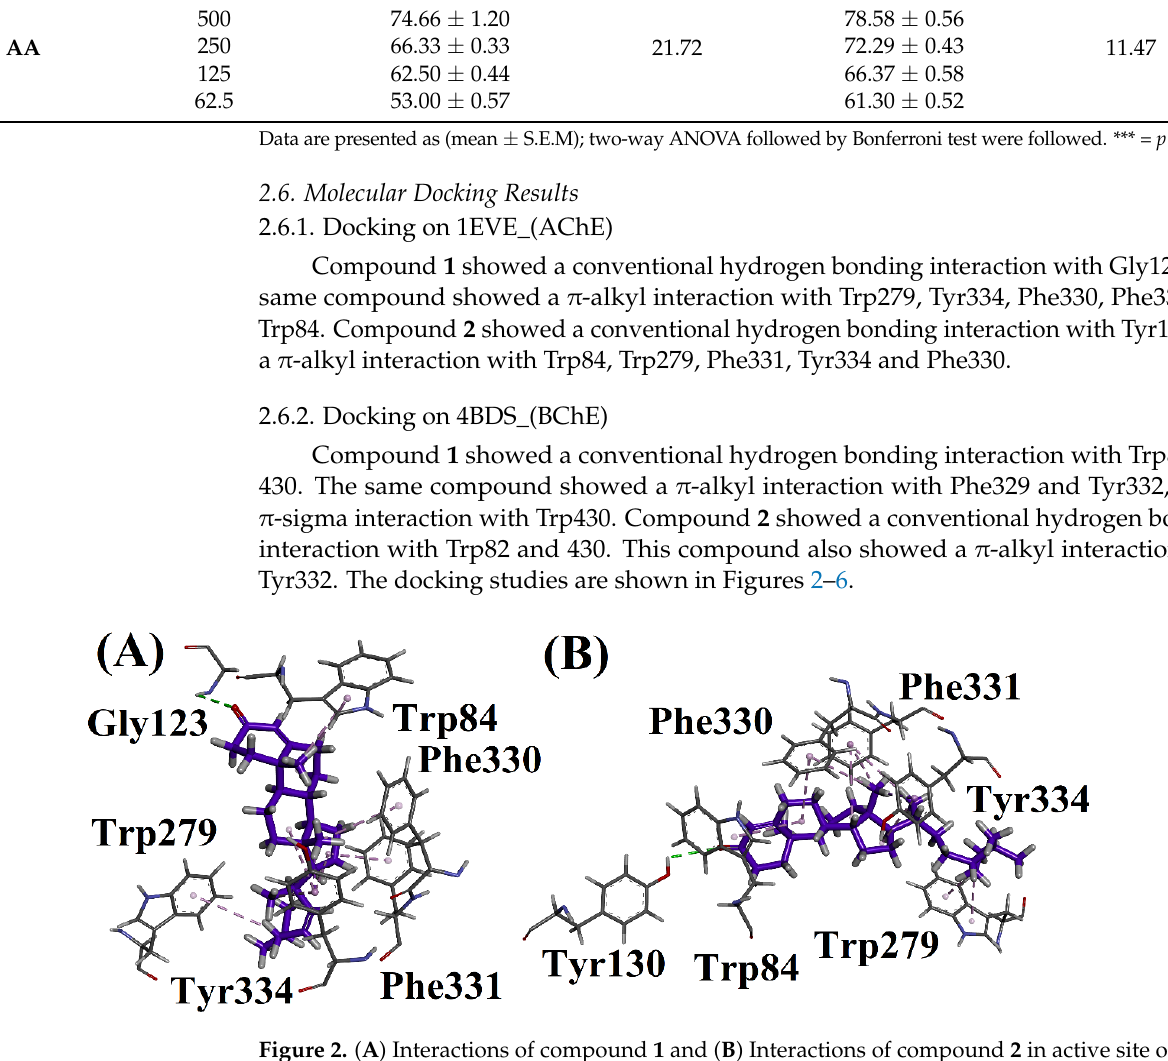
Figure 2. ( A ) Interactions of compound 1 and ( B ) Interactions of compound 2 in active site of